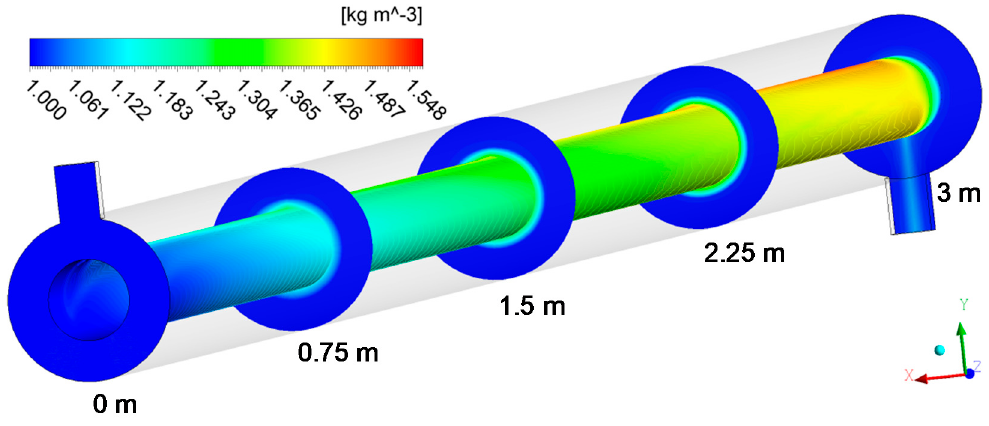
Figure 15. Oil concentration field inside the shell and tube module for T 0 = 75 °C (Case 7).